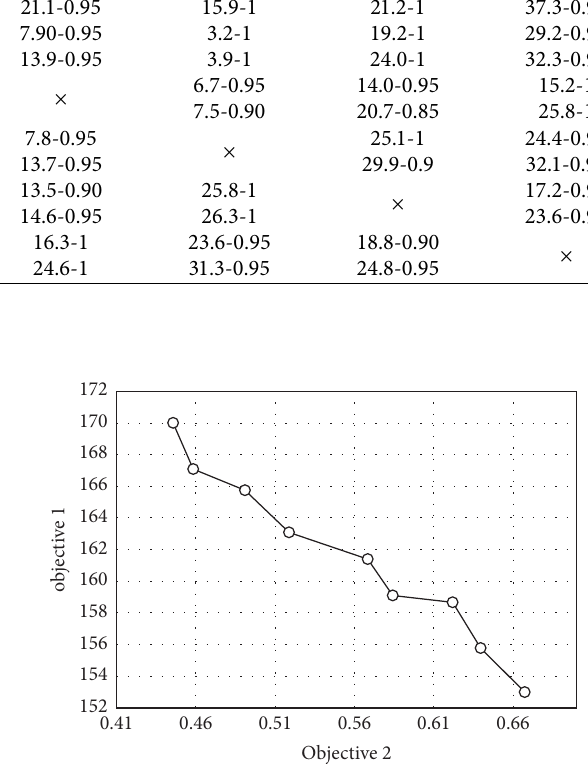
Figure 14: Approximate Pareto optimal for the studied Case I. Figure